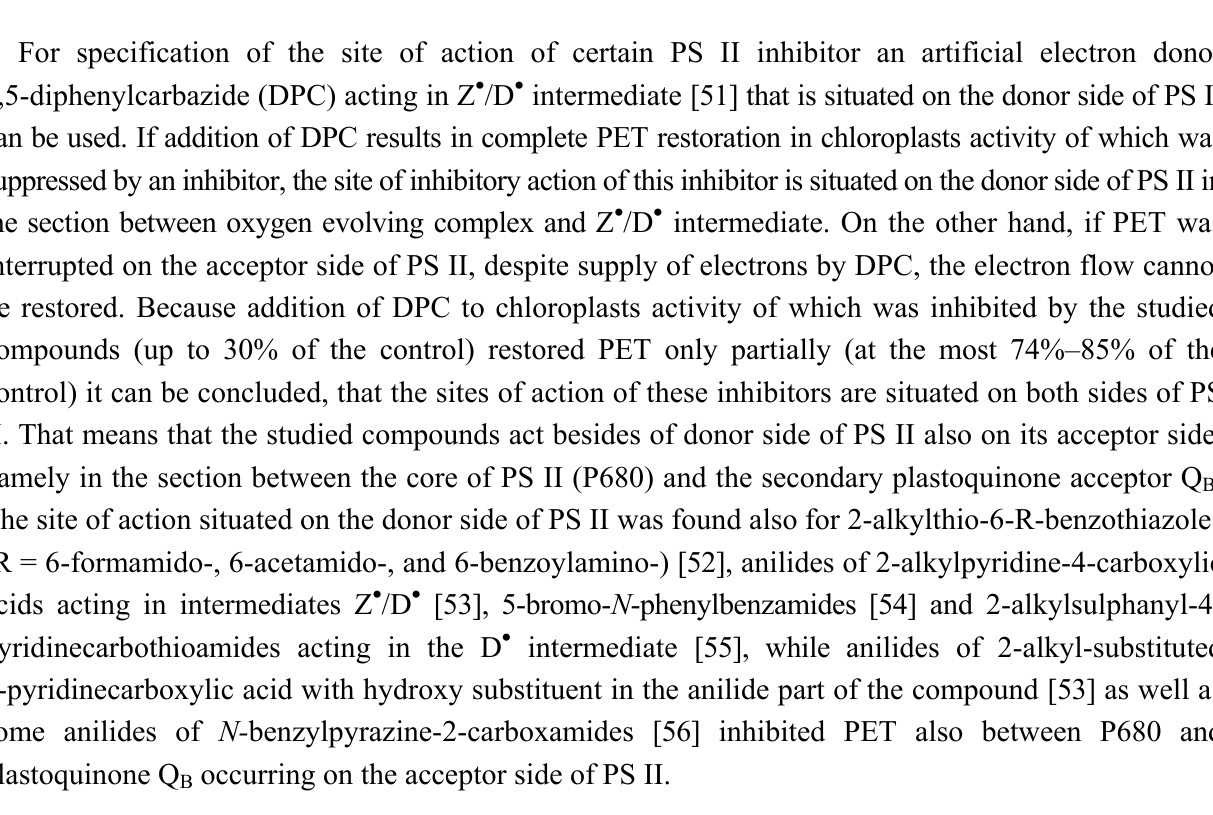
Figure 2. Fluorescence emission spectra of chlorophyll a in untreated spinach chloroplasts in presence of compound 8b : 0, 0.06, 0.12, 0.24, 0.48 and 0.72 mmol/L (curves from top to = 436 nm). Chlorophyll concentration in chloroplast suspension was constant, bottom; λ ex 10